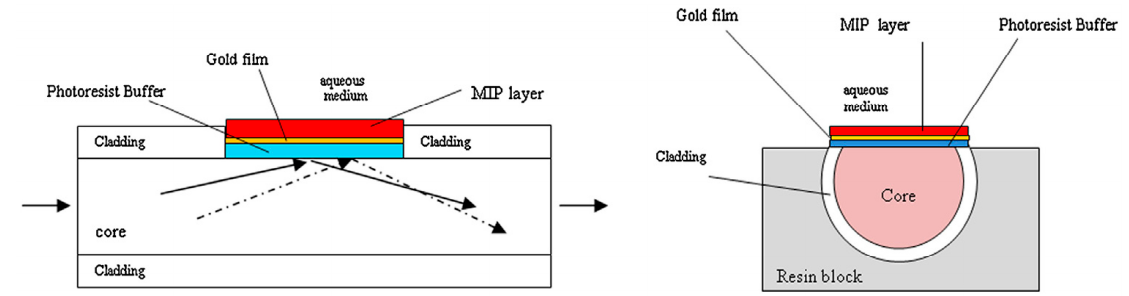
Figure 20. Plastic optical fiber SPR-based TNT sensor. ( Left) Longitudinal-sectional diagram of the sensor. It depicted the gold thin film for the SPR generation, and the MIP external TNT sensitive layer. ( Right ) Cross-section view of the sensor showing the side-polished sensitive region. Reprinted with permission from Ref. [122].